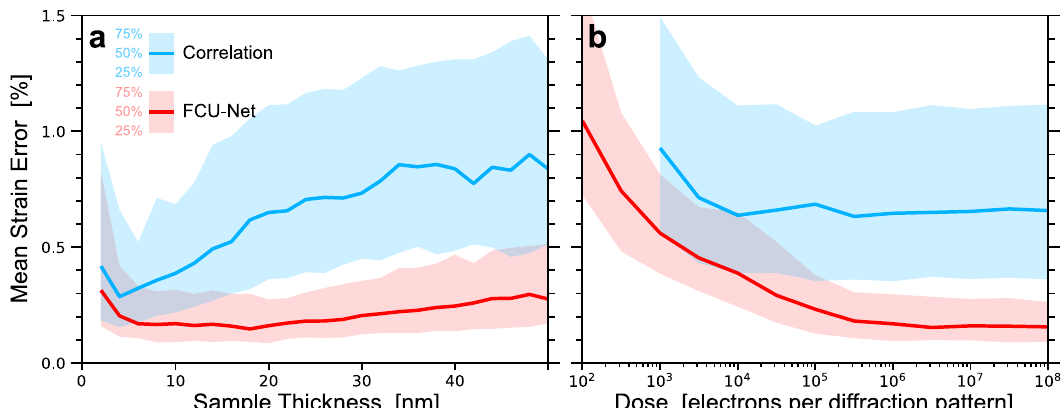
Fig. 3 Mean strain error of simulated diffraction patterns for 415 crystals and orientations. Strain error comparison between correlation and FCU-Net strain measurement, a as a function of sample thickness, and b as a function of electron dose per pattern for 20 nm thick samples. Solid line correspond to the median error, and the shaded regions show the interquartile range, for FCU-Net (red) and correlation (blue) methods,